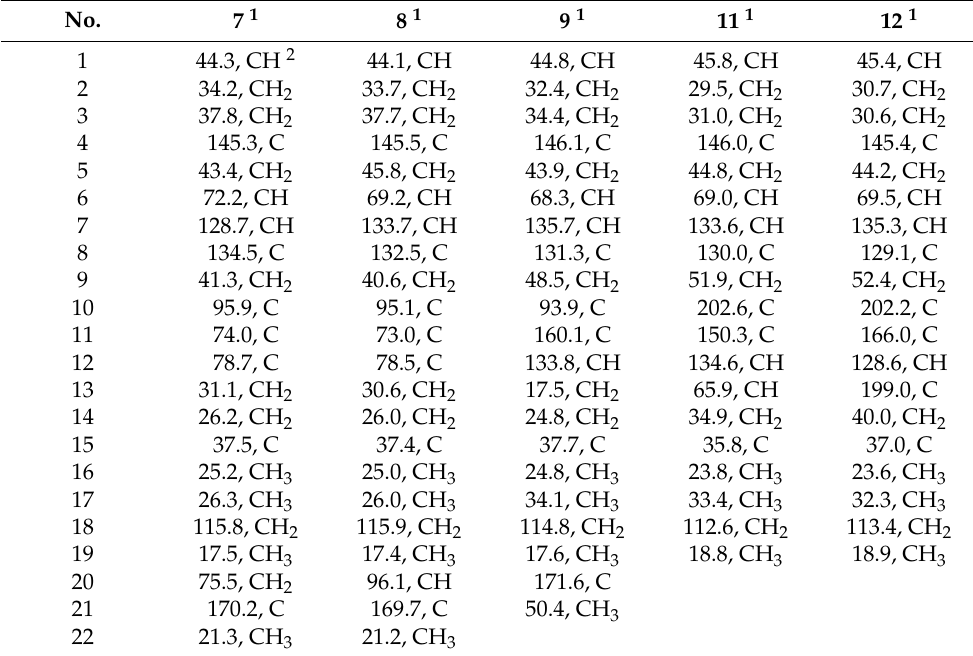
Table 4. 13 C NMR spectroscopic data of compounds 7 – 9 , 11 , and 12 .